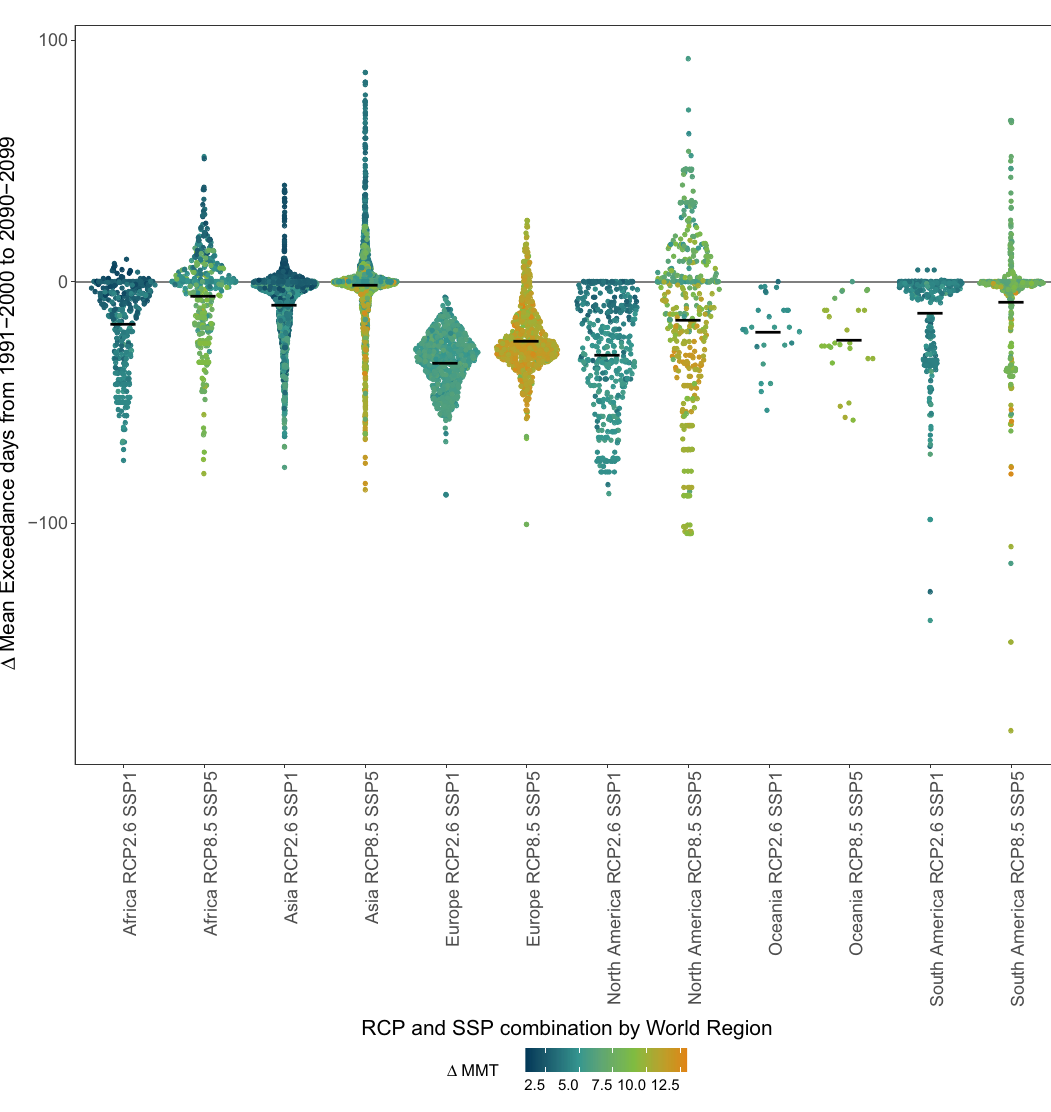
Figure 7. Regional disparities in (cid:31) MMT 2100–2000 and (cid:31) EXD 1991–2000 to 2090–2099 for the selected scenario combinations RCP2.6 paired with SSP1 and RCP8.5 paired with SSP5. Midbar indicates the mean of the (cid:31) EXD distribution across the sample